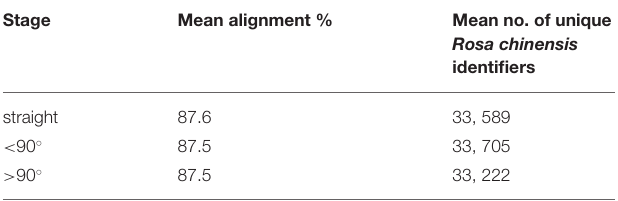
TABLE 1 | Alignment statistics of transcriptome sequences to the Rosa chinensis genome.